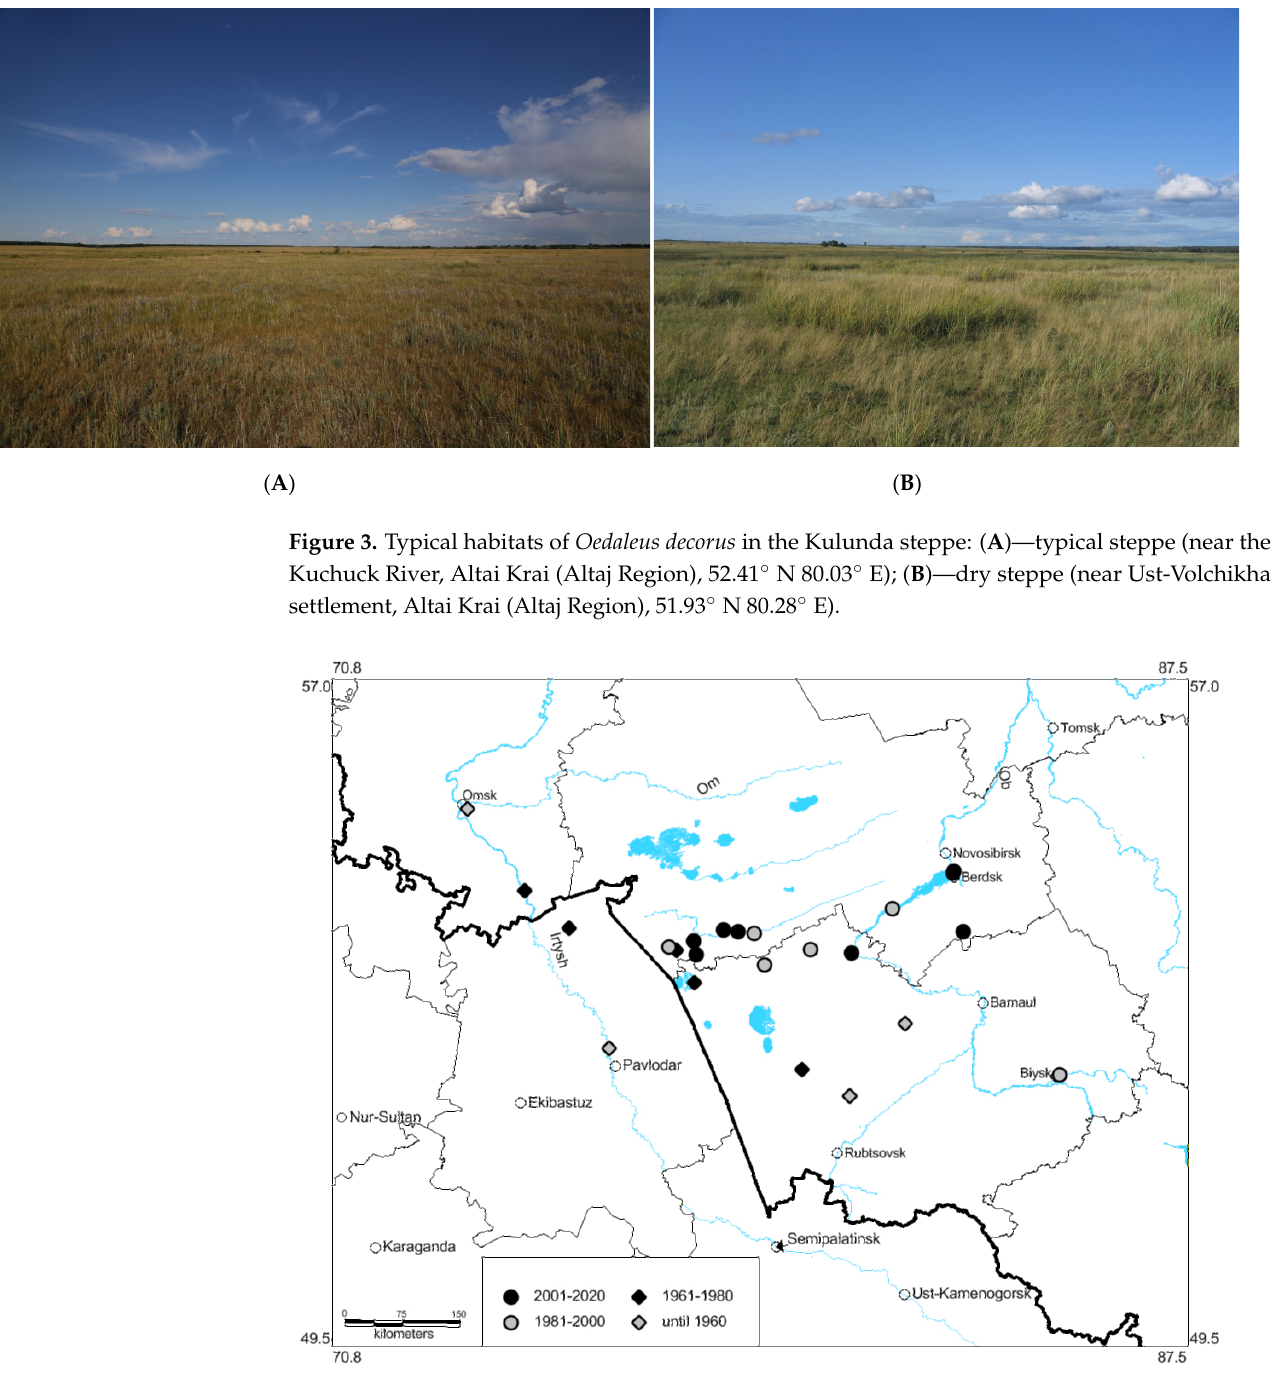
Figure 4. Changes of the known northernmost and north-easternmost localities of Oedaleus decorus in the south-eastern part of the West Siberian Plain from the beginning of the 20th century.